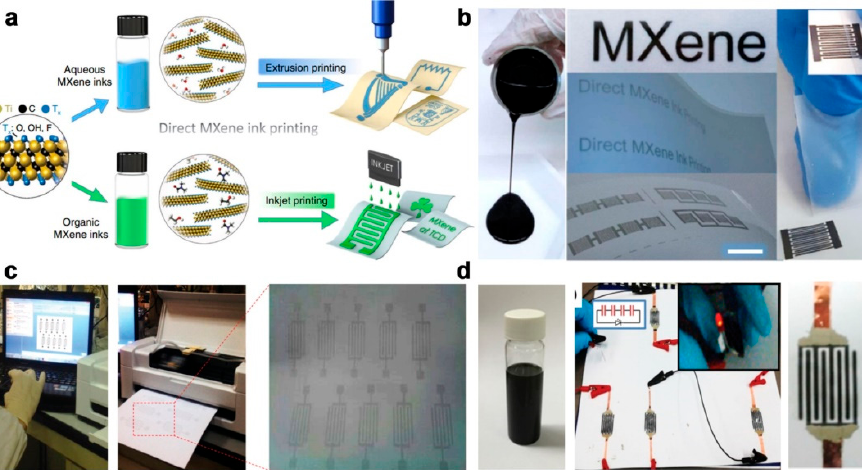
Figure 9. ( a ) Schematic illustration of the ink printing process for fabricating the flexible on-chip MSCs; ( b ) Photography of the MXene ink and printed MSC devices. The figure has been reproduced with permission from Springer Nature [63]; ( c ) Inkjet printing of MSC array via a “home computer and printer” using prepared EG ink; ( d ) Photography of the EG ink and printed MSC devices. The figure has been reproduced with permission from Wiley [64].